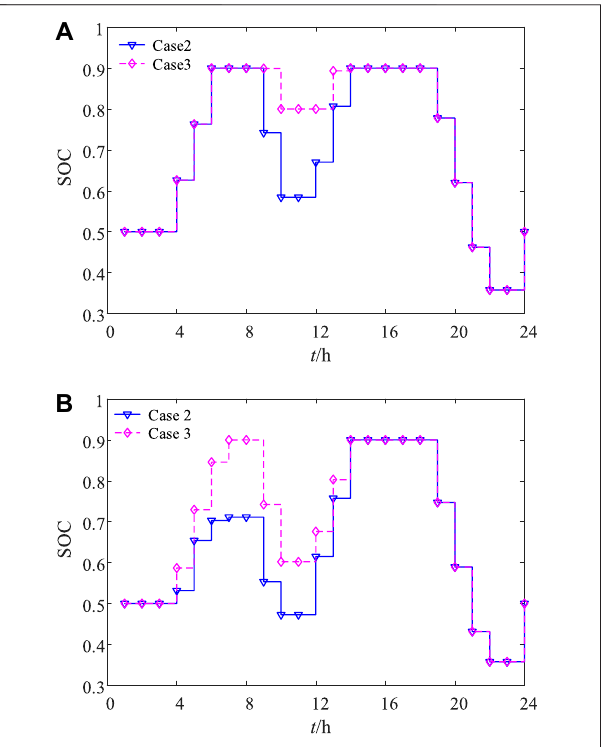
FIGURE 7 | The SOC of ES in Cases 2 and 3, (A) ES 1, and (B) ES